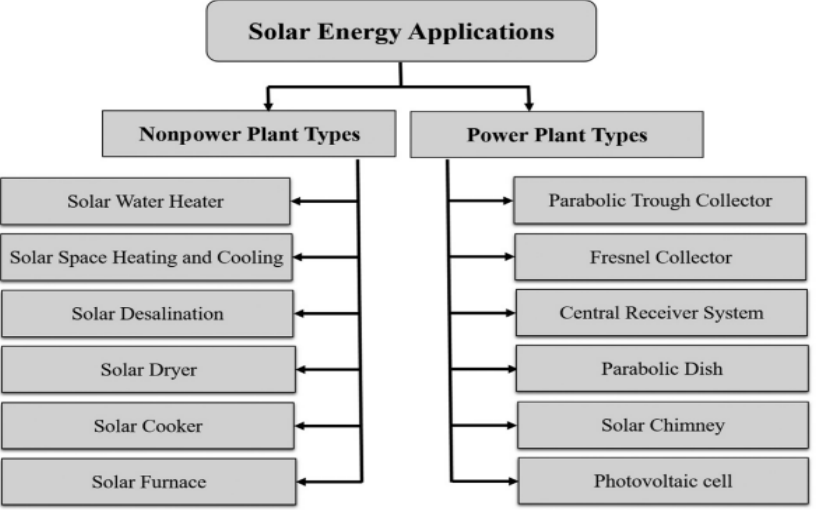
Figure 2. Applications for various forms of solar energy [3]. Reproduced with permission from Ajarostaghi and Mousavi (2022), © Academic press, 2022.